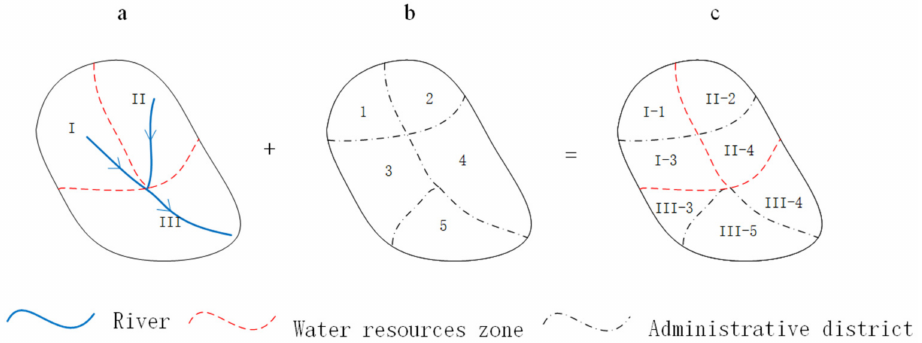
Figure 1. Division of water resource zone ( a ) and administrative district ( b ) into socio-hydrological units ( c ).